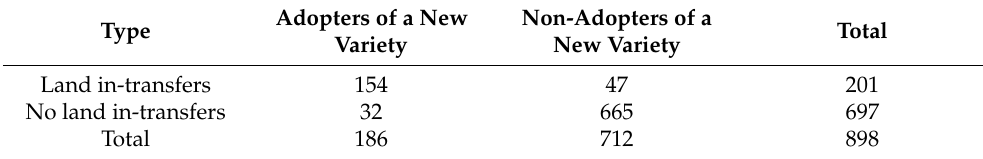
Table 2. The overall distribution of new variety adoption and land transfers. Adopters of a New Type